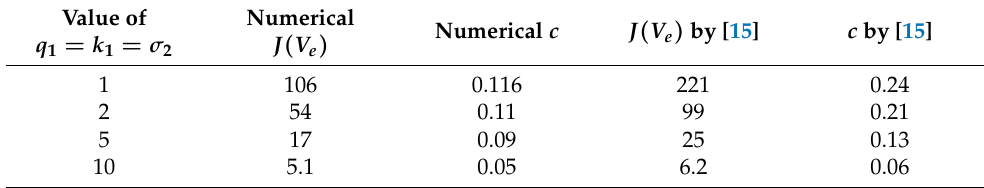
Table 2. The results of comparison of the total viral load and the wave speed obtained in the numerical simulation of the full system with the results obtained by analytical formulas from [15] for the second reduced model. The increase in coefficients q 1 , k 1 , and σ 2 leads to better correspondence. Parameters q 1 , k 1 , and σ 2 are measured in h − 1 , J ( V e ) is measured in copy/cm 2 , and c is in cm/h. Values of other parameters are D = 0.01, σ 1 = 0.1, k 3 = 0.1, k 4 = 0.1, q 2 = 0.1, A 0 = 1000, with the same units as in Figure 2. Corresponding values of the parameters of system (75) are a = 0.1 (h × copy) − 1 , b = 0.1 copy/(h × cell), β = 0.1 h − 1 , U 0 = 1000 cell/mL, and κ 1 = κ 2 =